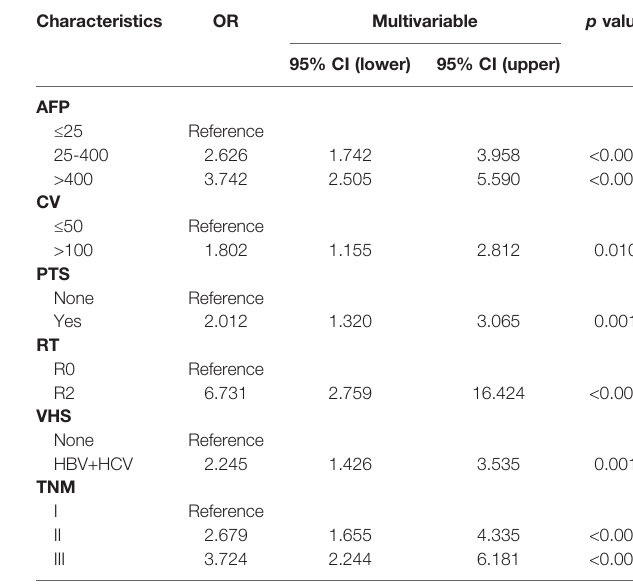
TABLE 3 | Multivariable Cox regression model analyses of OS for